Question: Briefly state, in one sentence, what is plotted here.
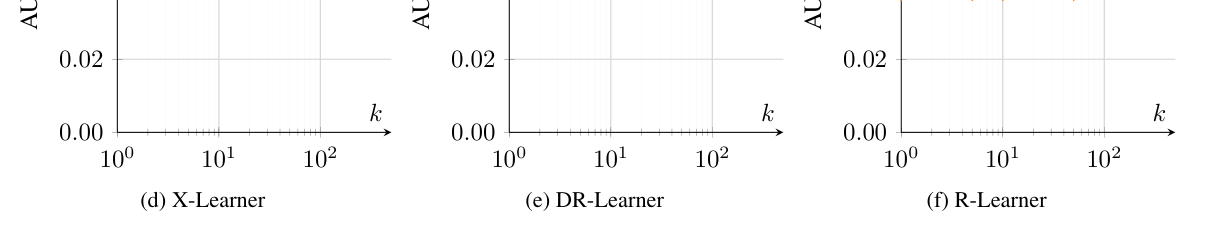
Answer: What Is the Effect of the Number of Sampling Iterations k? We show performance in terms of AUQC (higher is better) for the different metalearners on the Synthetic data set. We fix the sigmoid parameter σ = 1 and train with default hyperparameters.